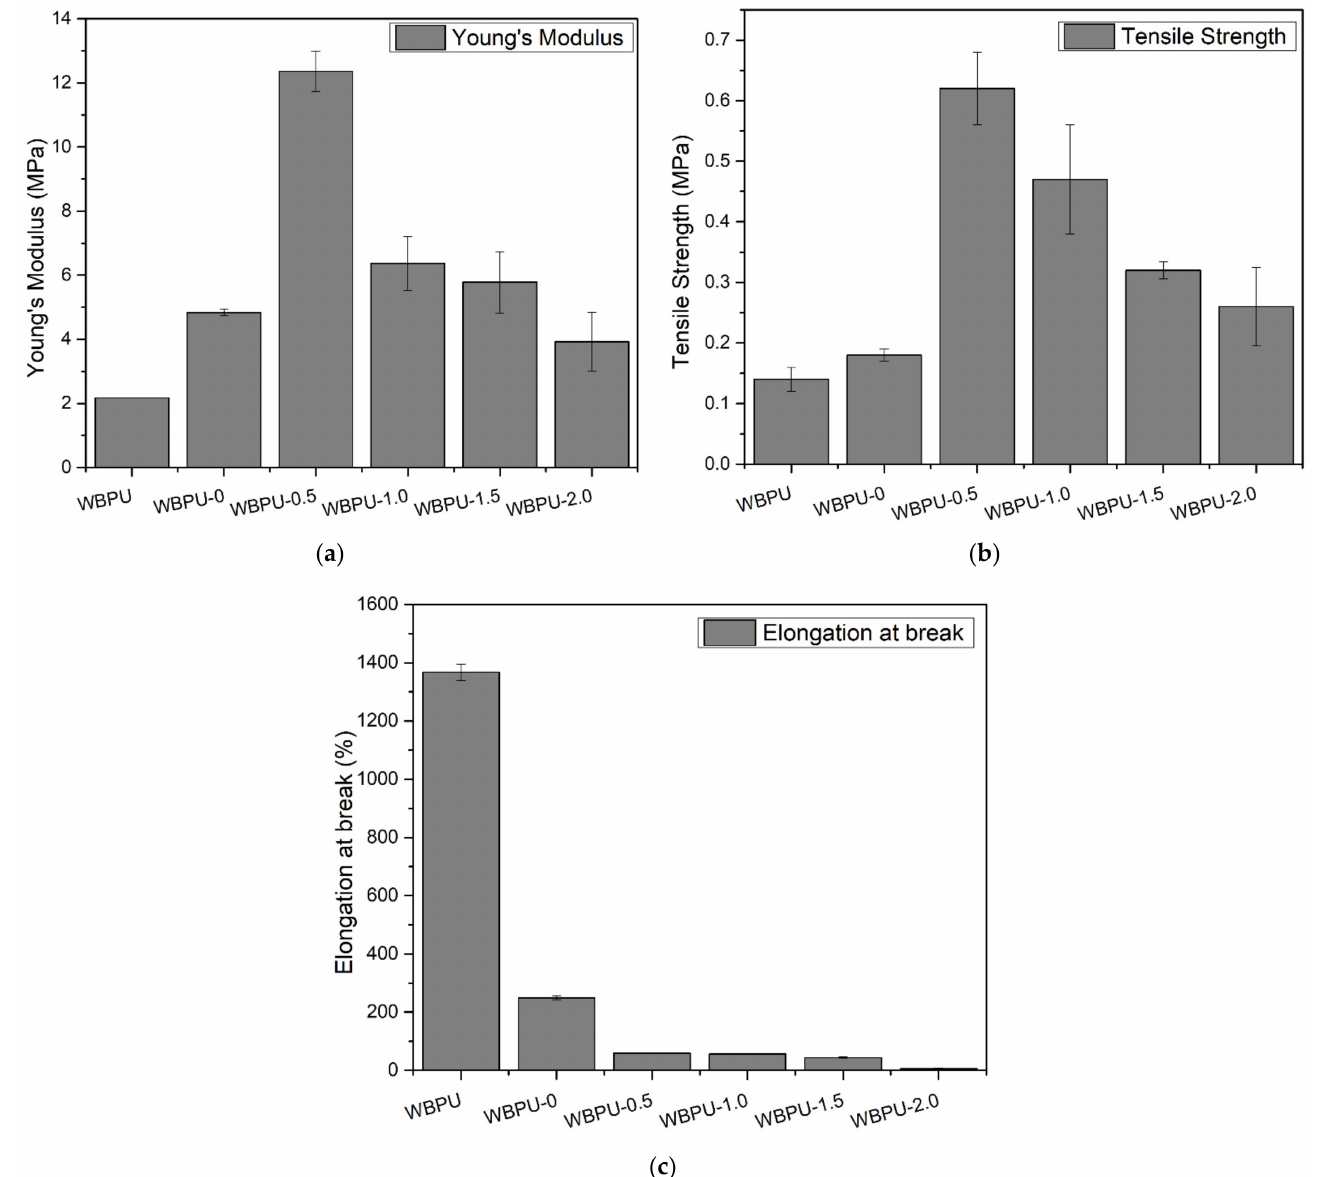
Figure 6. Mechanical properties of nanocomposite films: ( a ) Young’s modulus; ( b ) Tensile strength and ( c ) Elongation at